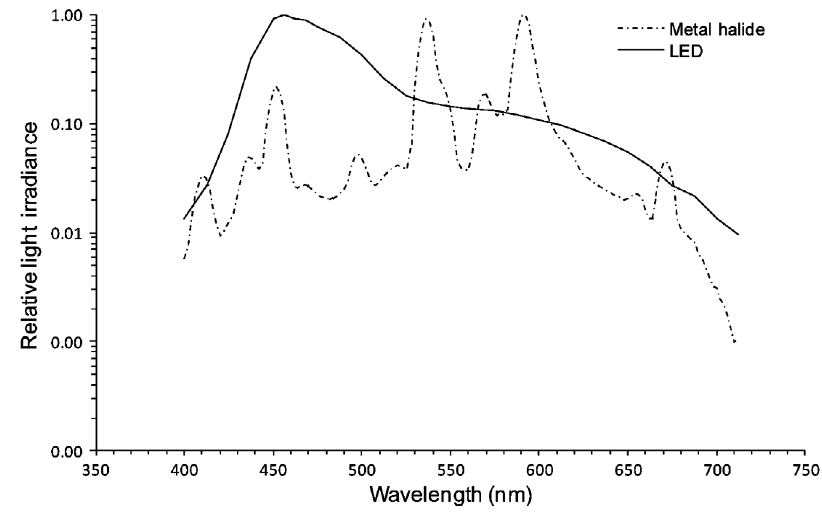
Fig. 2. Spectral distribution of the light emitted by the LED and metal halide lamps. The LED lamps were built from selected individual LEDs (neutral white, royal blue, blue and cyan) to generate a normal light dis- tribution with slightly more energy in the blue-green colour